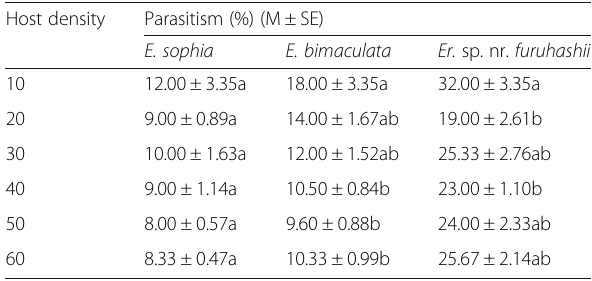
Table 1 Parasitism rate of parasitoid in different density Bemisia tabaci nymph